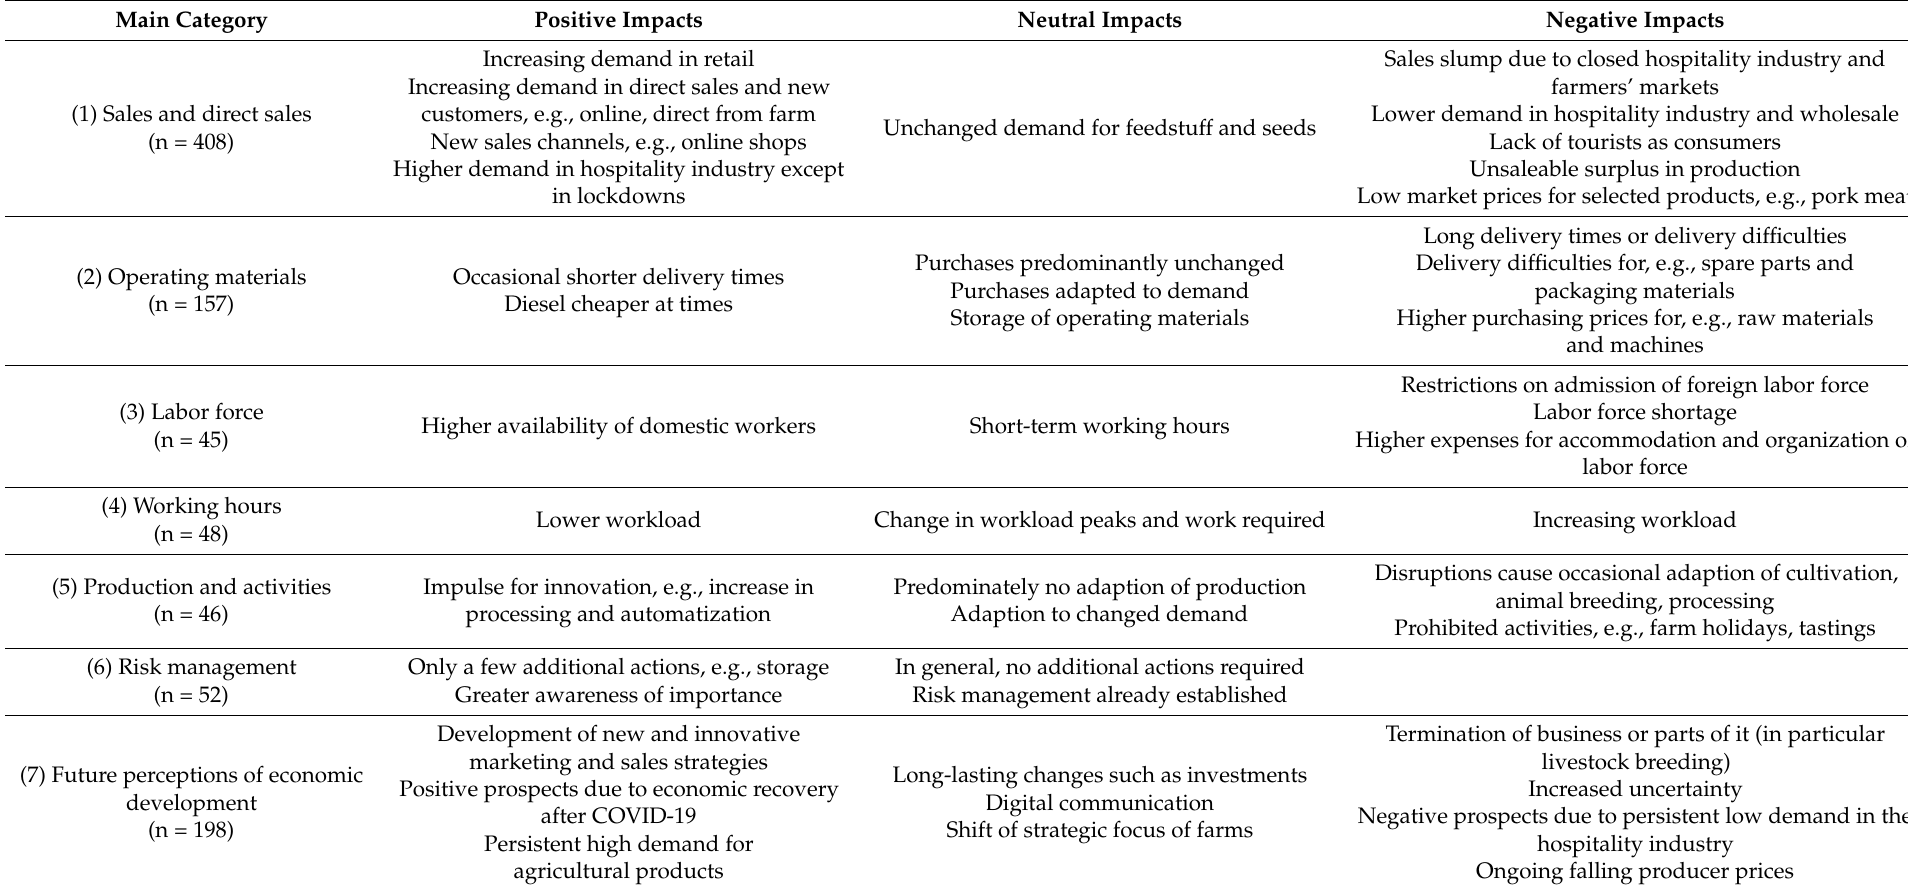
Table A1. Positive, neutral, and negative impacts of COVID-19 on Austrian agriculture in 13 main categories; n = total number of assigned text